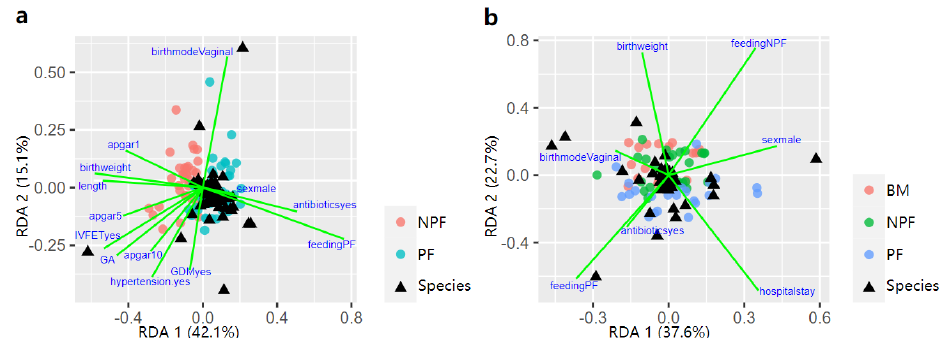
Figure 6. Influencing factors of the infant gut microbiota composition between NFP and PF group showed by RDA triplot at week 1 ( a ), and all the three groups at week 6 ( b ). RDA, redundancy analysis; BM, breastmilk; PF, probiotics formula; NPF, non − probiotics formula.